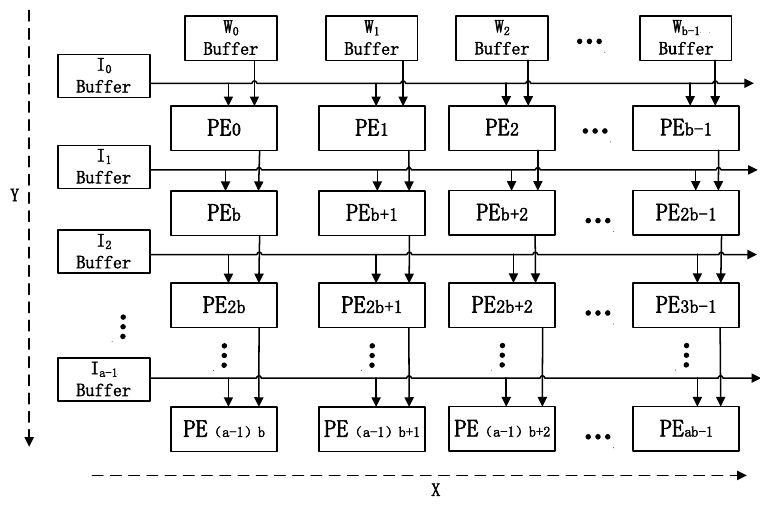
Figure 9. The structure of MMA.